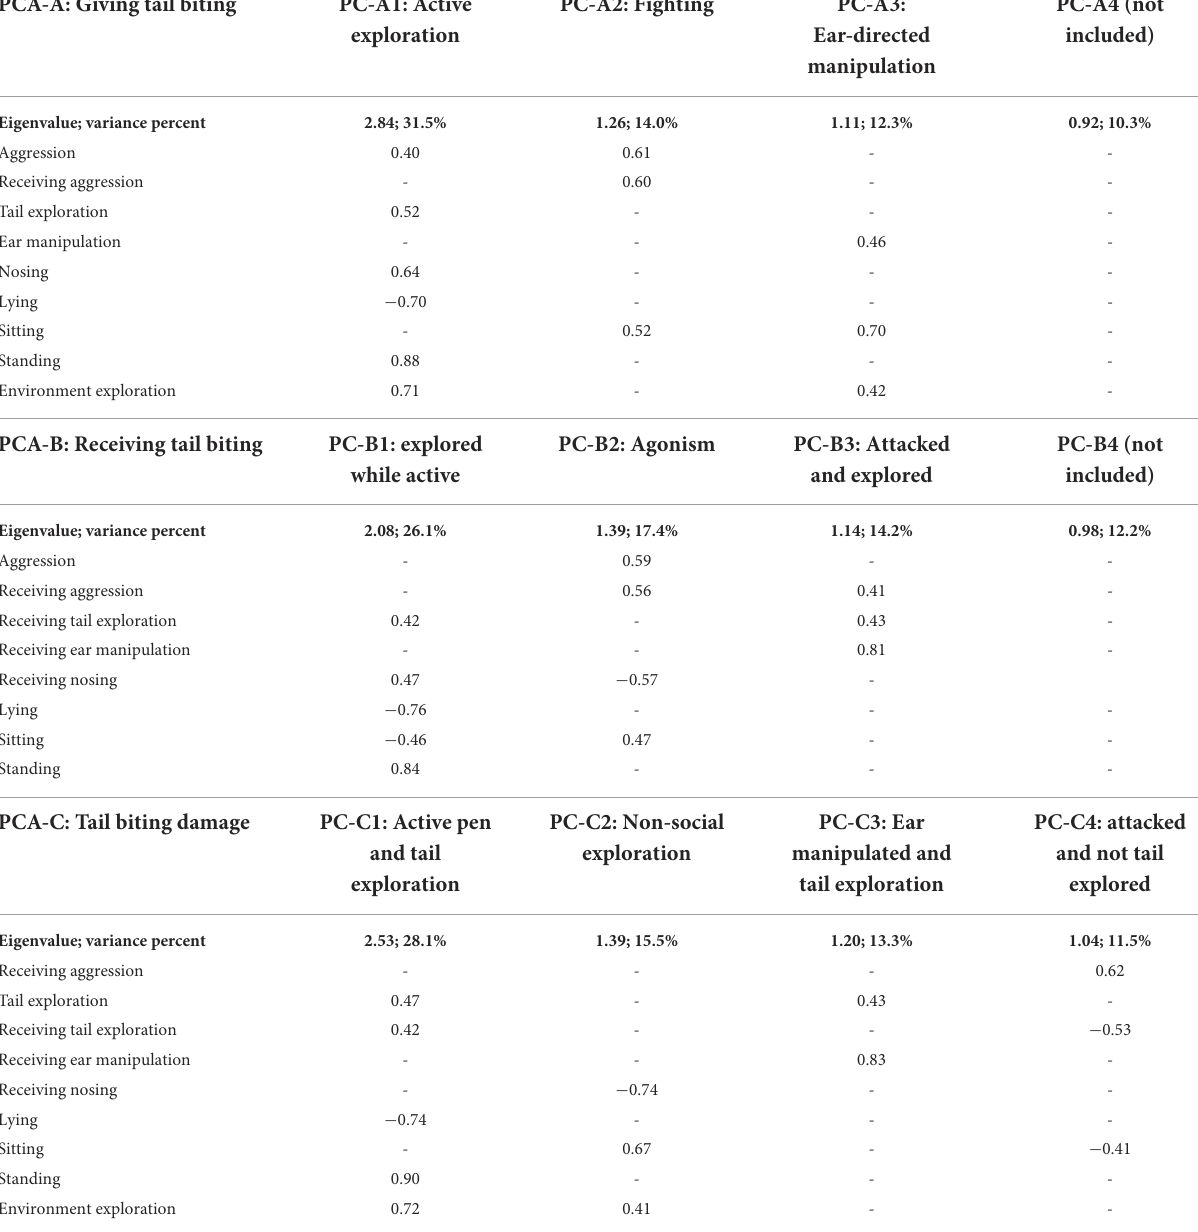
TABLE 2 Results of the PCAs for giving tail biting (PCA-A), receiving tail biting (PCA-B), and tail biting damage (PCA-C). PCA-A: Giving tail